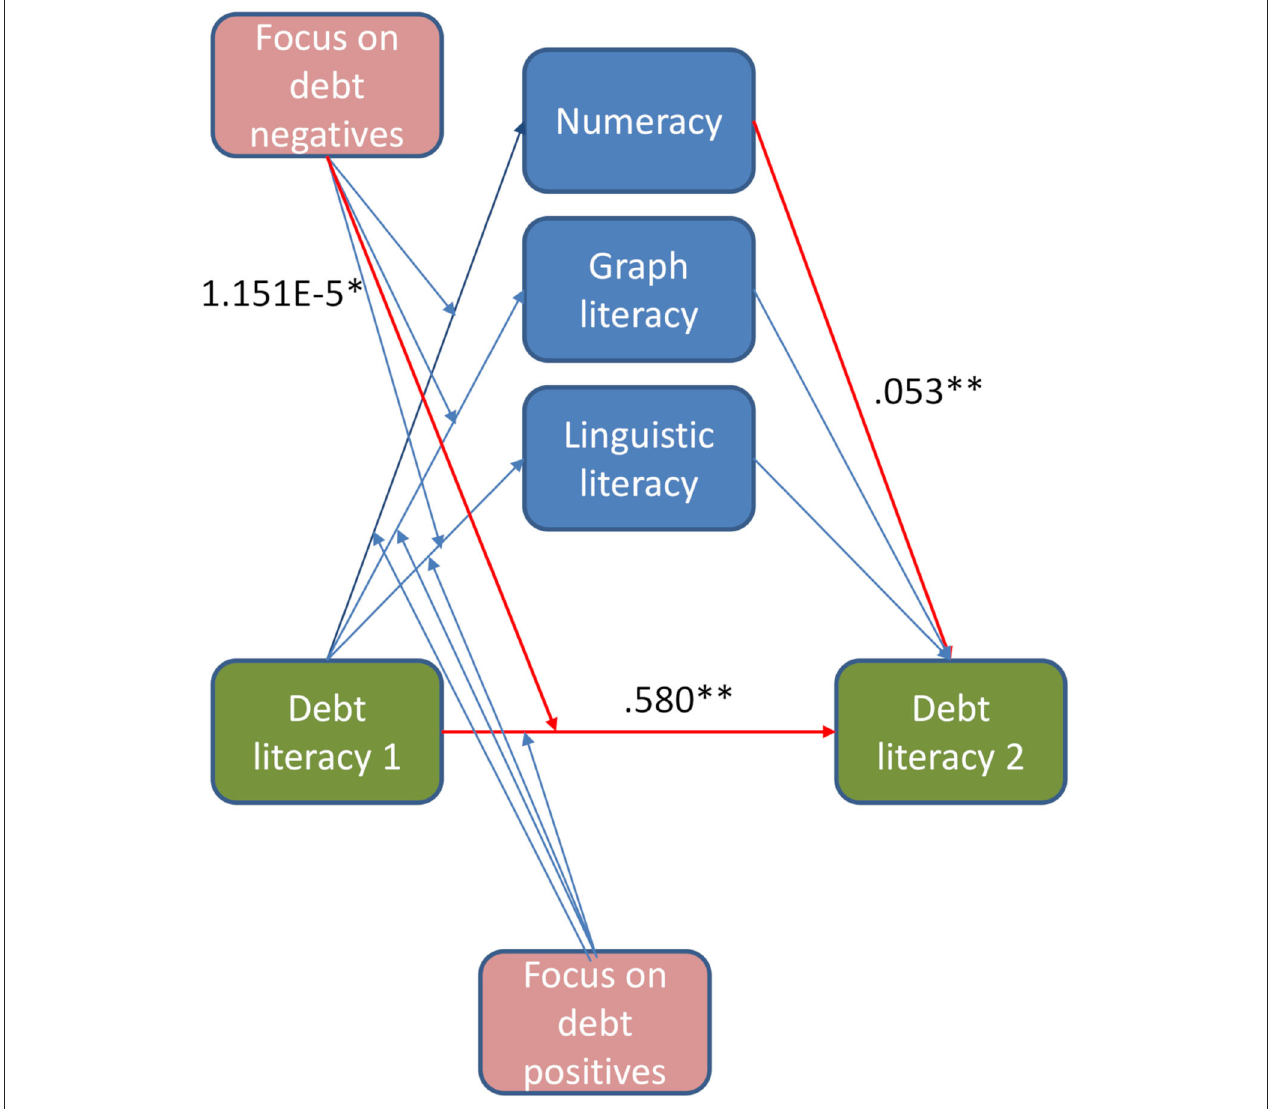
FIGURE 6 | The role of visual attention focus on debt positives, debt negatives, numeracy, graph literacy, and linguistic literacy in debt education ab . a Unstandardized beta coefficient weights from the mediation test. b Significance: * p < 0.05, ** p <